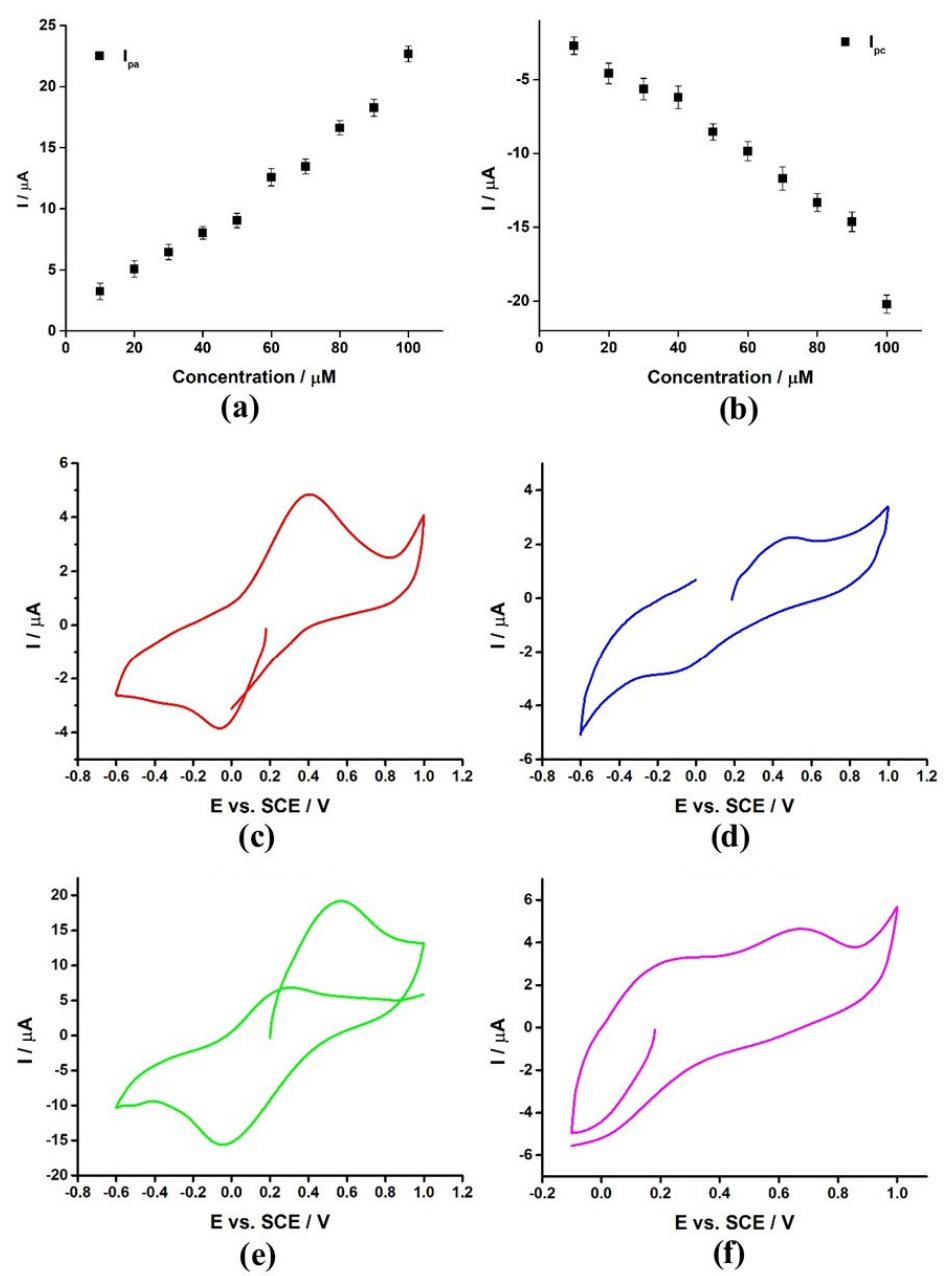
Figure 5. ( a , b ) Linear dependence of I vs. concentrations of NO 3 − and ( c – f ) CV curves of GA@PAni- CNT at the different start and end potentials.